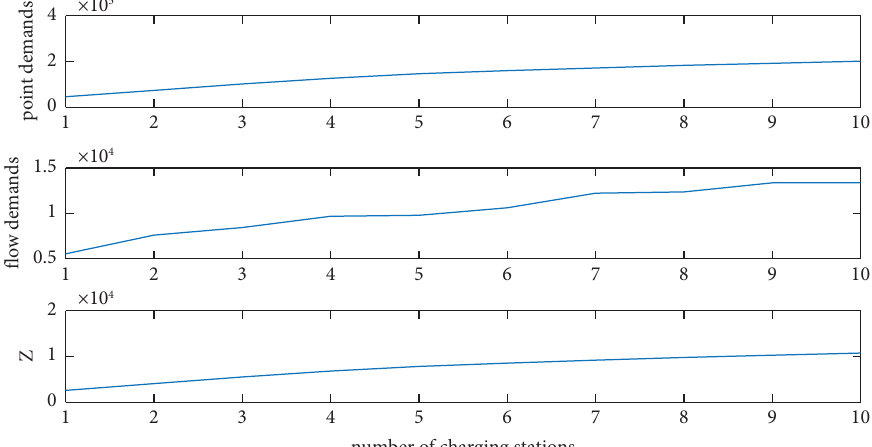
Figure 8: Covered point demands and covered path demands and the objective values with the number of charging stations increasing under θ �